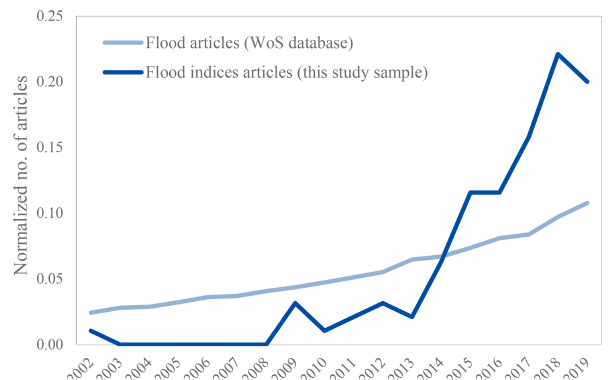
Figure A1. Normalized number of flood vulnerability indices and flood articles according to the Web of Science database. For the flood articles search, the keyword “flood*” was